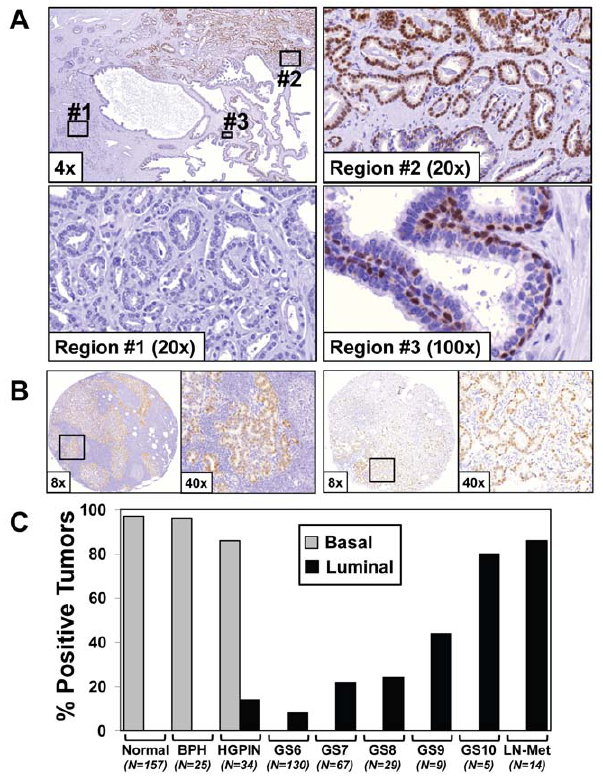
Figure 1. Sox2 is uniformly expressed in a subset of hormone naı¨ve prostate tumors and castration-resistant metastases. A ) Immunohistochemical staining of Sox2 demonstrating representative nuclear basal epithelial staining (dark red) in normal glands (Region # 3), and two distinct tumor regions that are either uniformly Sox2- positve (Region # 2) or Sox2-negative (Region # 1). B ) Expression of Sox2 in representative castration-resistant metastatic lesions. The box in the 8 6 magnification corresponds to the region shown in the 40 6 image. C ) Percentage and distribution of Sox2 expression among prostate disease states. In normal, BPH, and HGPIN tissues, Sox2 is expressed in basal-epithelial cells (Grey Bars). Positive expression is defined by more than 50% of the cancer cells positive with a relative intensity of 1 or more on a scale of 0–3. In cancer tissues and metastases, Sox2 is either uniformly expressed or absent, and the percentage of Sox2-positive tumors increases with Gleason Score (Black Bars). BPH: Benign Prostatic Hyperplasia; HGPIN: high-grade prostatic intraepithelial neoplasia; GS: Gleason Score (N=number of individual patient specimens analyzed).